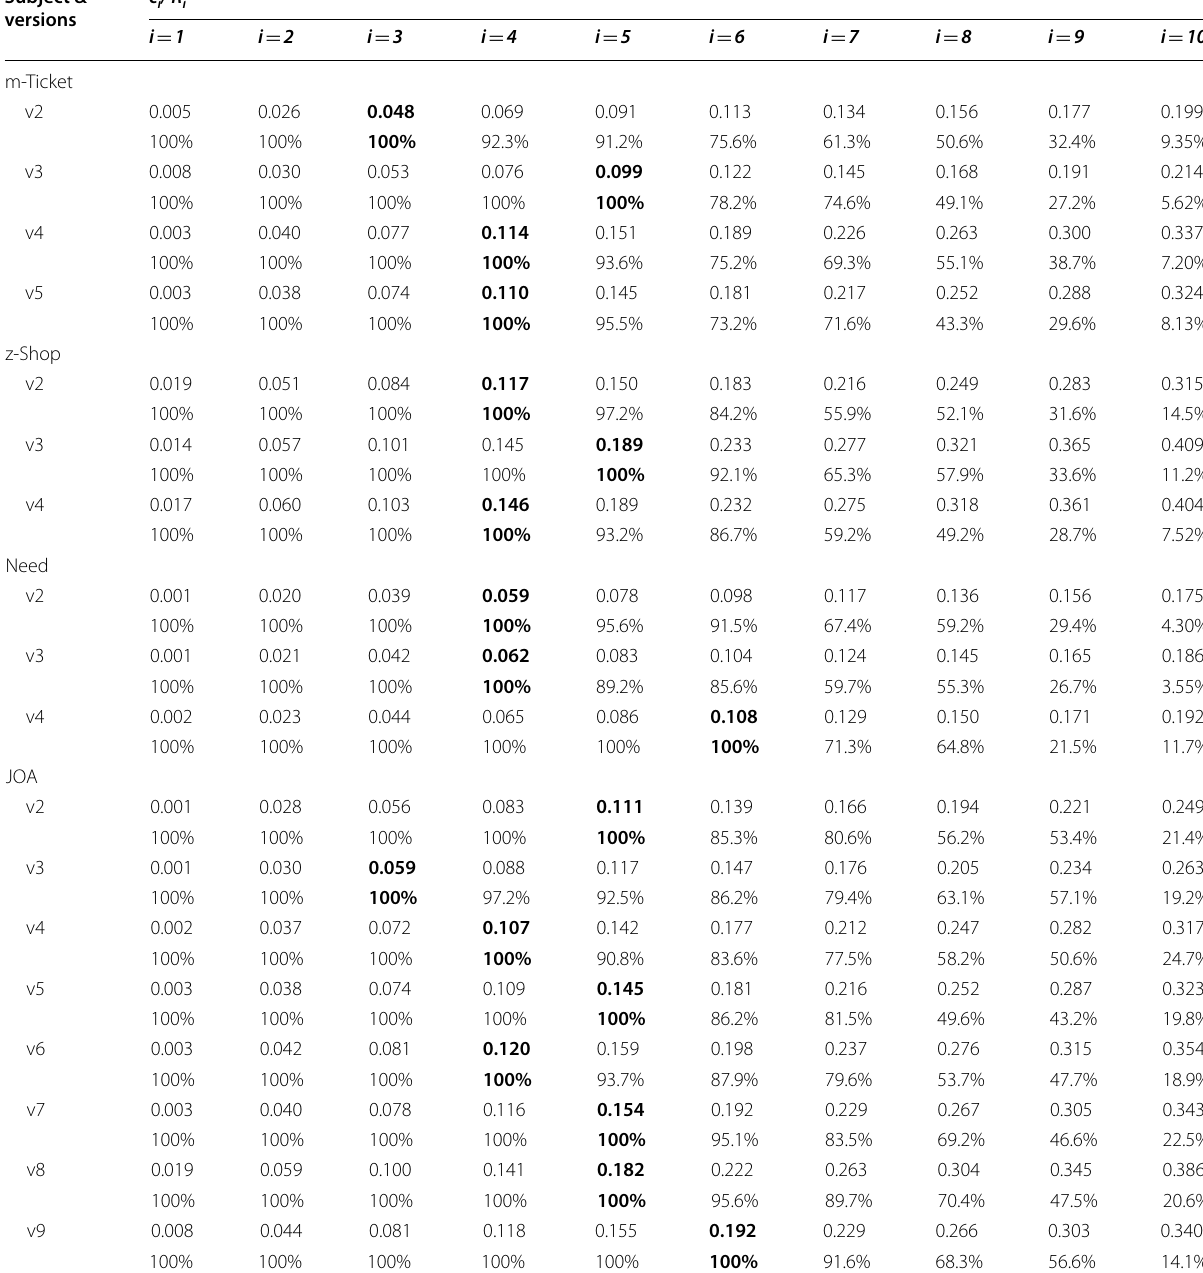
Table 3 Data of Experiment